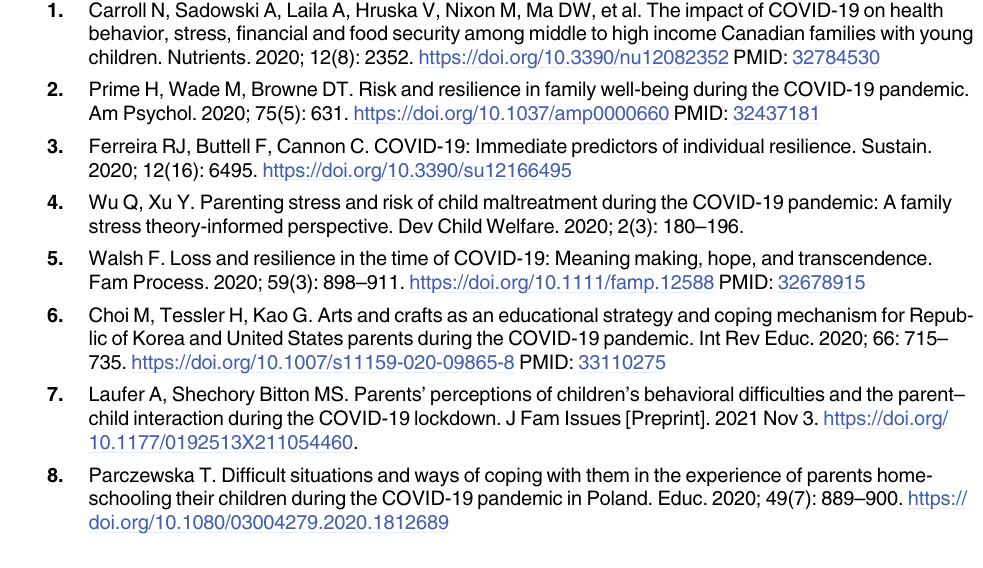
S2 Table. Differences in family pandemic-oriented personal evaluation scale factors before and during the COVID-19 pandemic. S3 Table. Interactions between family coping-strategy clusters before and during the COVID-19 pandemic on family quality of life scale factors during the